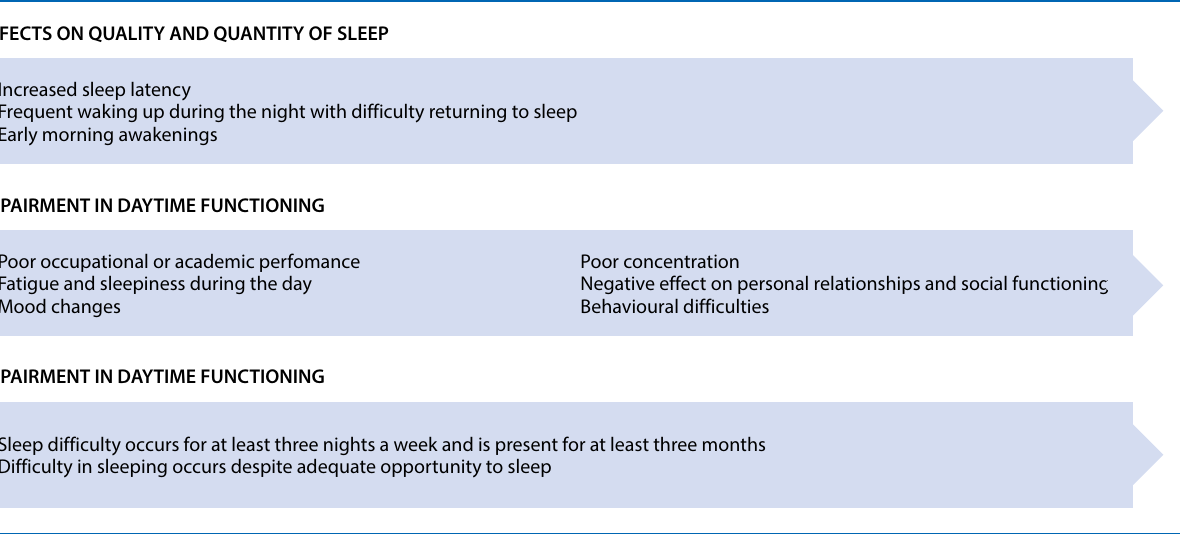
Figure 1 : Criteria for Diagnosis of Insomnia Disorder